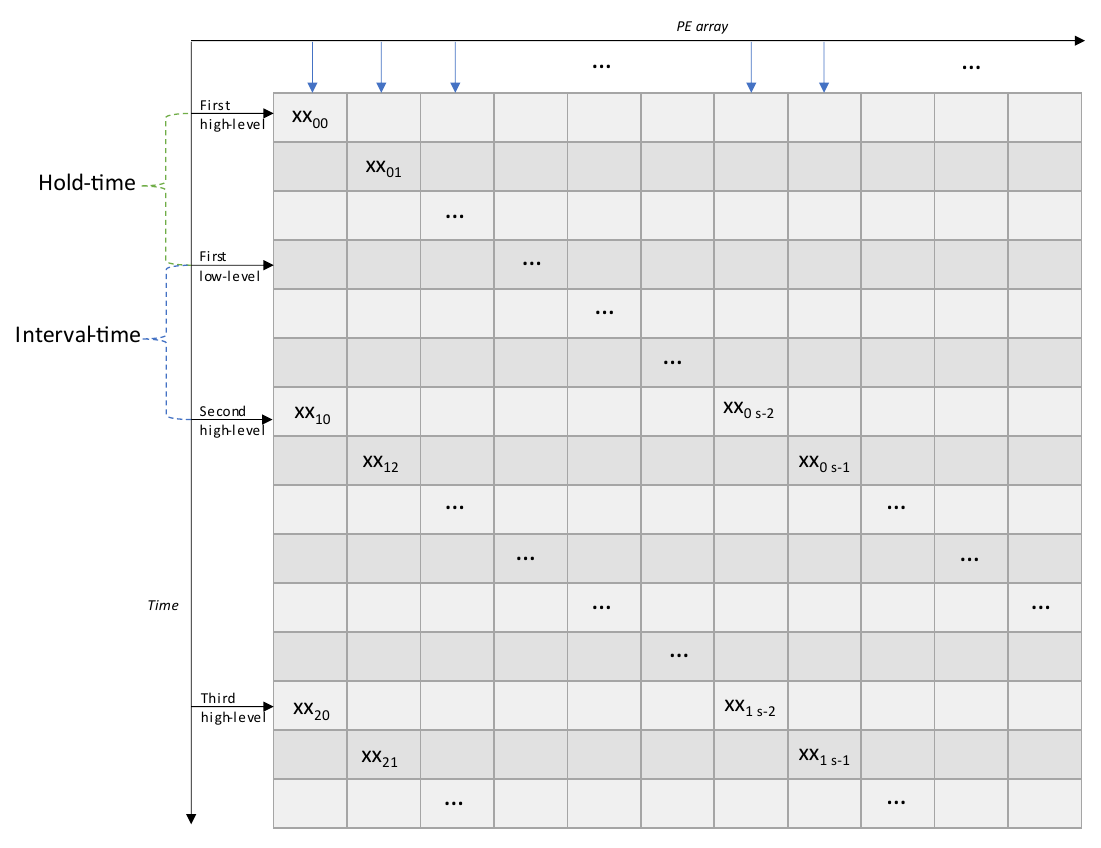
Figure 6. Data path optimization in the time dimension.